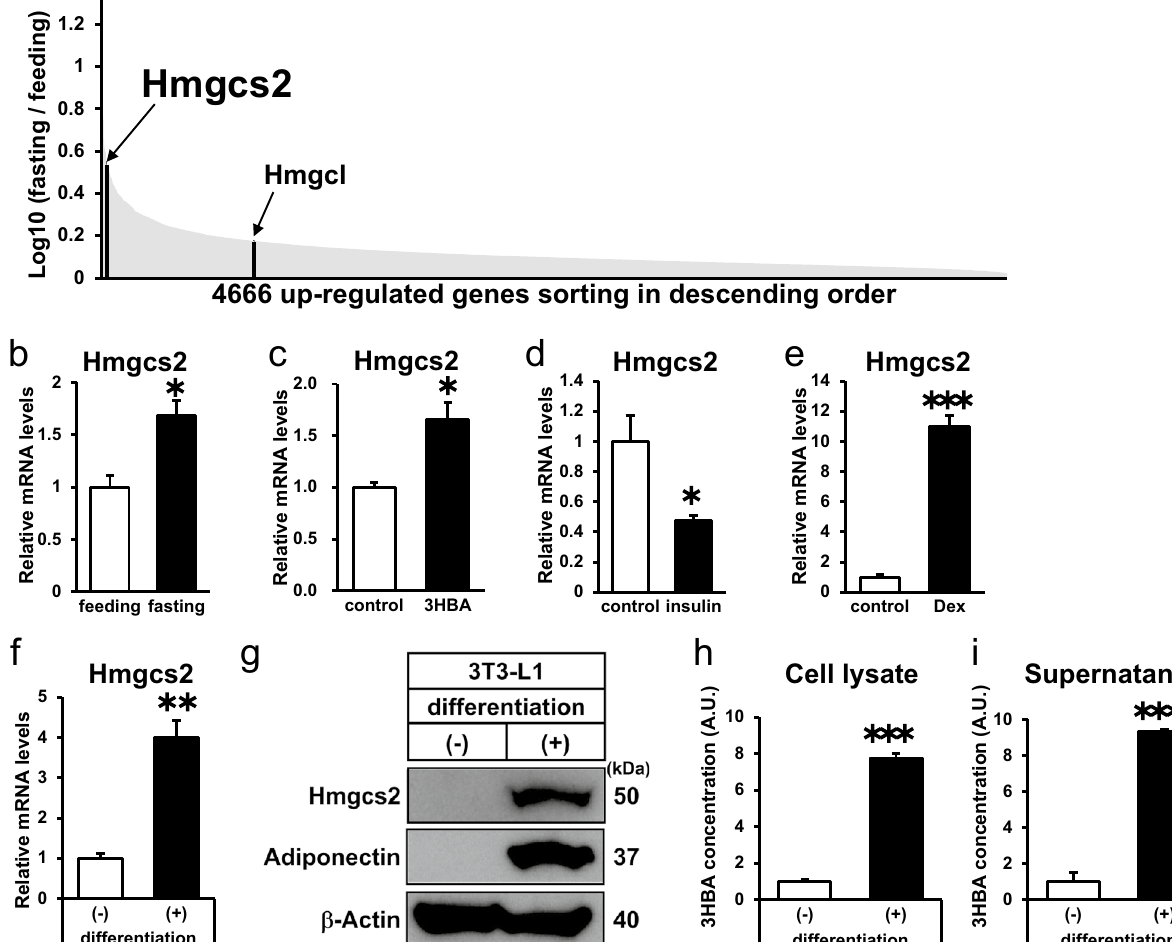
Figure 6. Hmgcs2 is expressed in adipose tissue in vivo and in vitro, and adipocytes produce and secrete 3HBA. ( a ) Schematic diagram of microarray analysis to identify fasting-inducing genes expressed in adipose tissue. The genes upregulated by fasting are sorted in descending order. The following Gene Expression Omnibus DataSet was used for the analysis: GSE46495 (fold-change > 2.0, p < 0.05; 4666 genes). ( b ) qRT–PCR of Hmgcs2 in epididymal adipose tissue from C57BL/6 J mice after 12 h of feeding and fasting. n = 3. ( c – e ) qRT–PCR of Hmgcs2 in differentiaed 3T3-L1 adipocytes after 24 h of treatment with 10 mM 3HBA ( c ), 1 nM insulin ( d ), and 1 µM dexamethasone ( e ). n = 3. ( f ) qRT–PCR of Hmgcs2. n = 3. ( g ) Intracellular protein of Hmgcs2. n = 1. ( h and i ) 3HBA concentrations in cell lysate ( h ) and cell culture supernatant ( i ) of differentiated and undifferentiated 3T3-L1 adipocytes. n = 3. For measurement of 3HBA, cell lysate was normalized per well of a 6 well plate, and culture supernatant was normalized per 2 mL media for a well of 6 well plate. Here cropped blots were displayed and all full-length blots are included in the supplemental Fig. S2. Data are mean ± SEM. * p < 0.05, ** p < 0.01, *** p < 0.001. A.U., Arbitrary